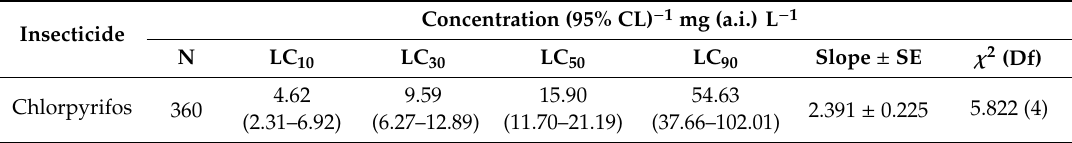
Table 1. Acute toxicity of chlorpyrifos on 3rd instar larvae of Harmonia axyridis .